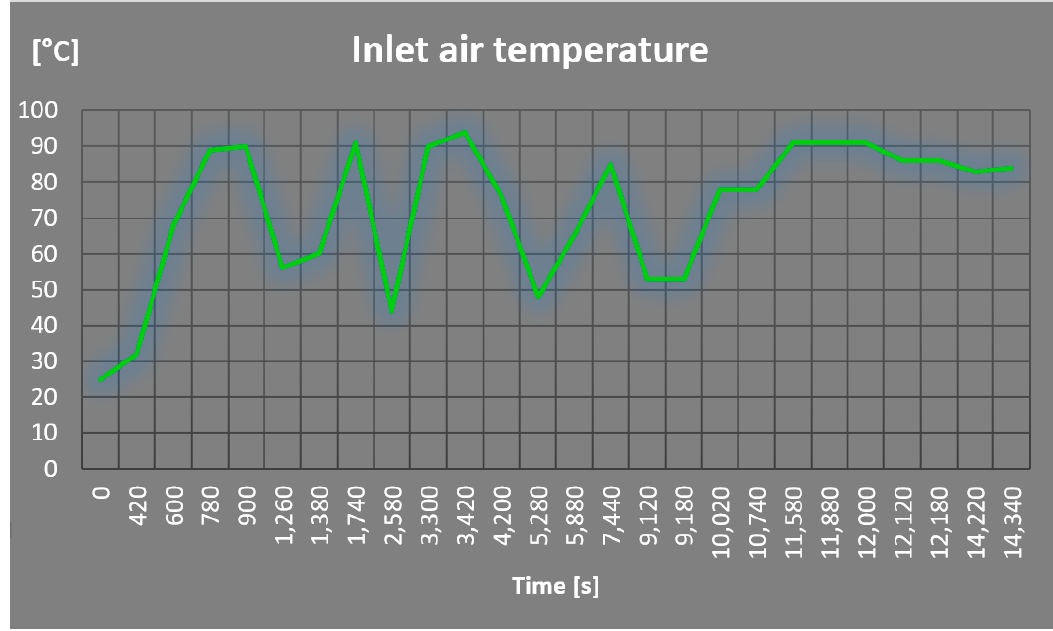
Figure 5. Trend of the air temperature at the outlet of the exchanger.